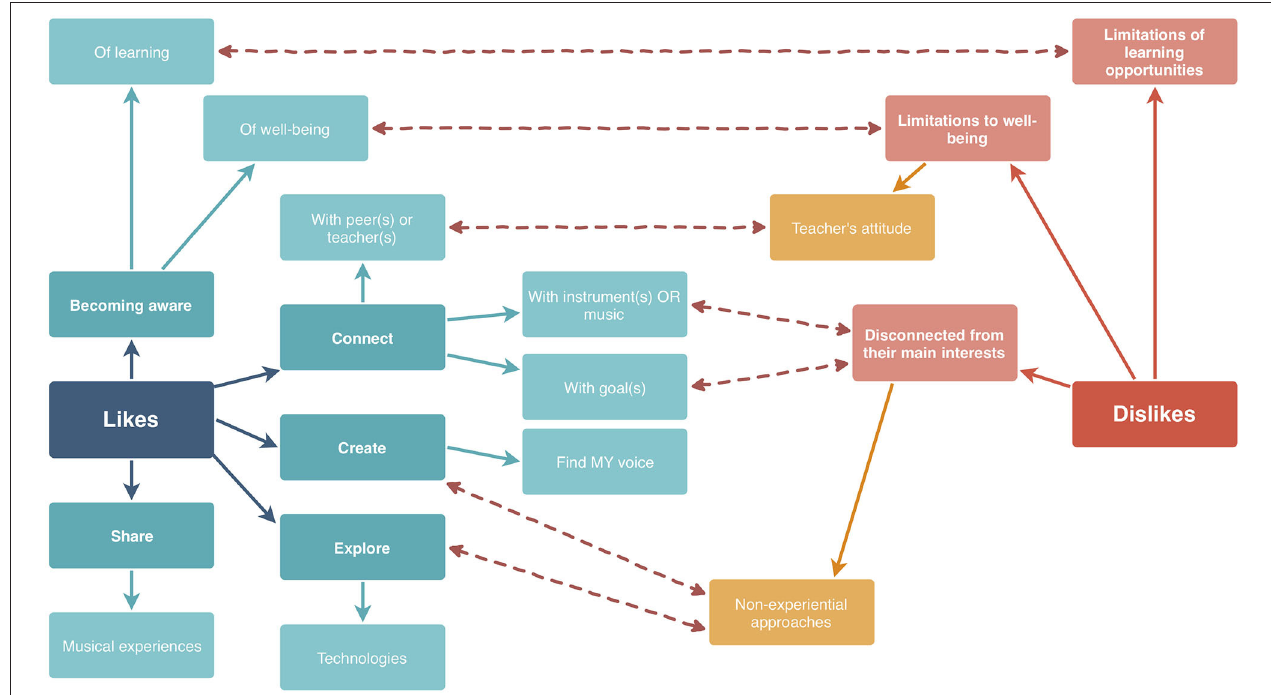
FIGURE 3 | Likes, dislikes and how they relate to each